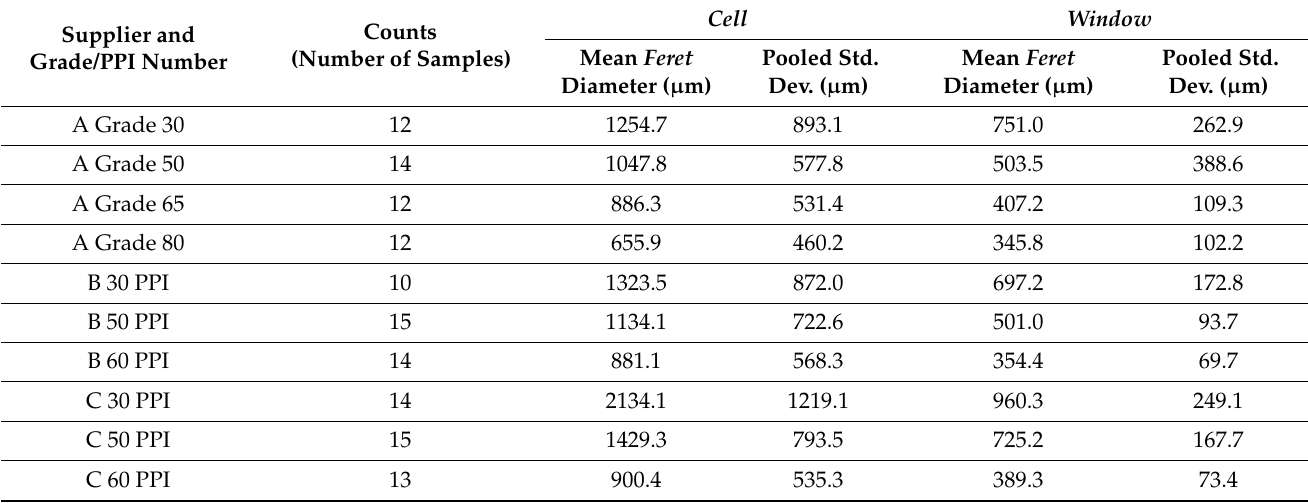
Table 4. The mean Feret diameter of the Cell and Window of CFF from suppliers A, B, and C.